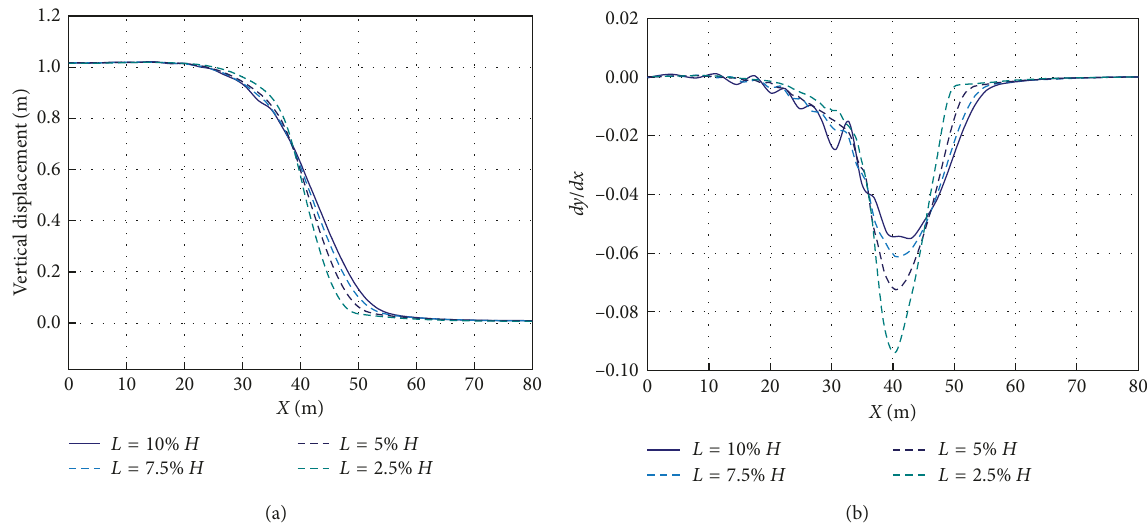
Figure 2: The displacement of the ground surface: (a) vertical displacement and (b) tilt